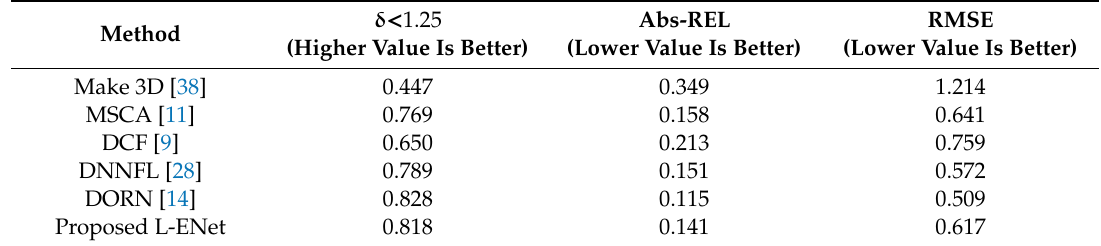
Table 1. Evaluation result on NYU Depth v2